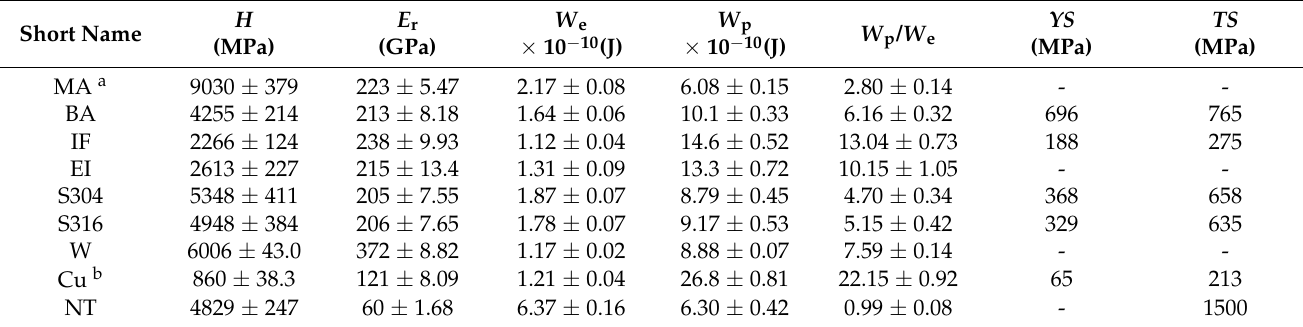
Table 3. Average values of H , W e , W p , and W p / W e obtained by nanoindentation tests ( F max = 9.8 mN; n = 30), along with yield stress (YS) and tensile strength (TS) obtained by tensile testes for various specimens.